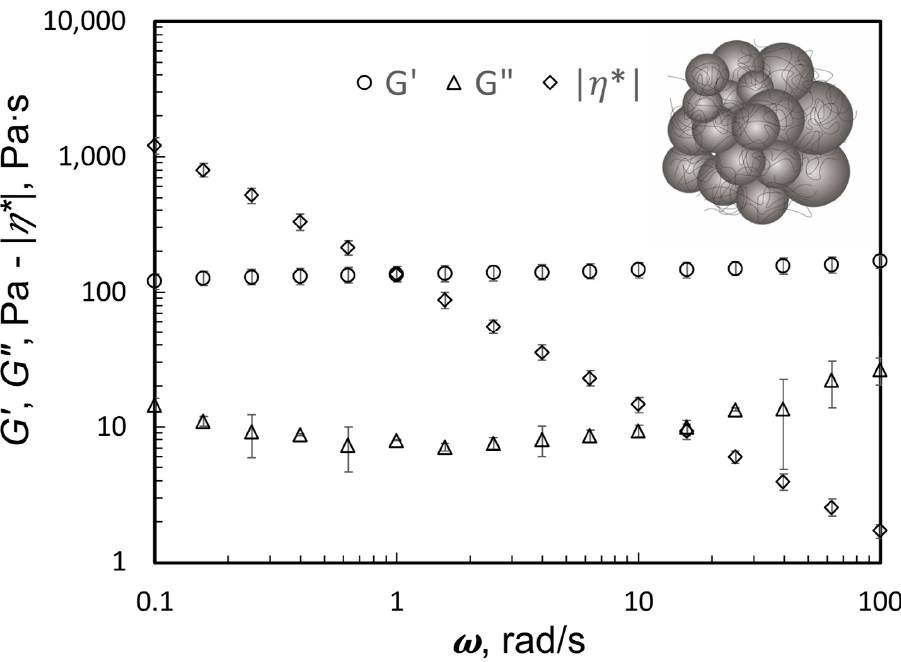
Figure A1. The dynamic properties (linear viscoelastic material functions of storage moduli, G ′ , loss moduli, G ″ , and the magnitude of complex viscosity, ∣ η * ∣ ) of the Carbopol ® hydrogel at a concentration of 0.12% by weight at 25 °C.